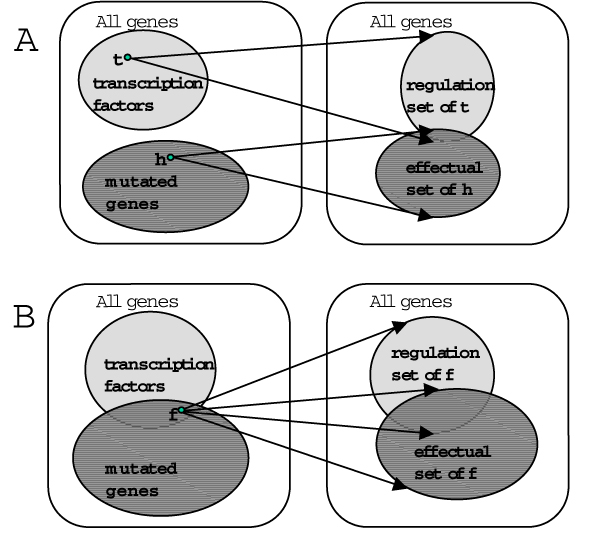
Illustration of the target set comparison. A In the ChIP network transcription factors are connected to their target genes (regulation set); in the mutant network the deleted genes are linked to all genes with differential expression in this particular mutant background (effectual set). B Some transcription factors are present in both networks (ChIP and mutant network); we can therefore compare the genomic localisation (regulation set) with the expression changes in the mutant cell (effectual set). Reproduced from [2]